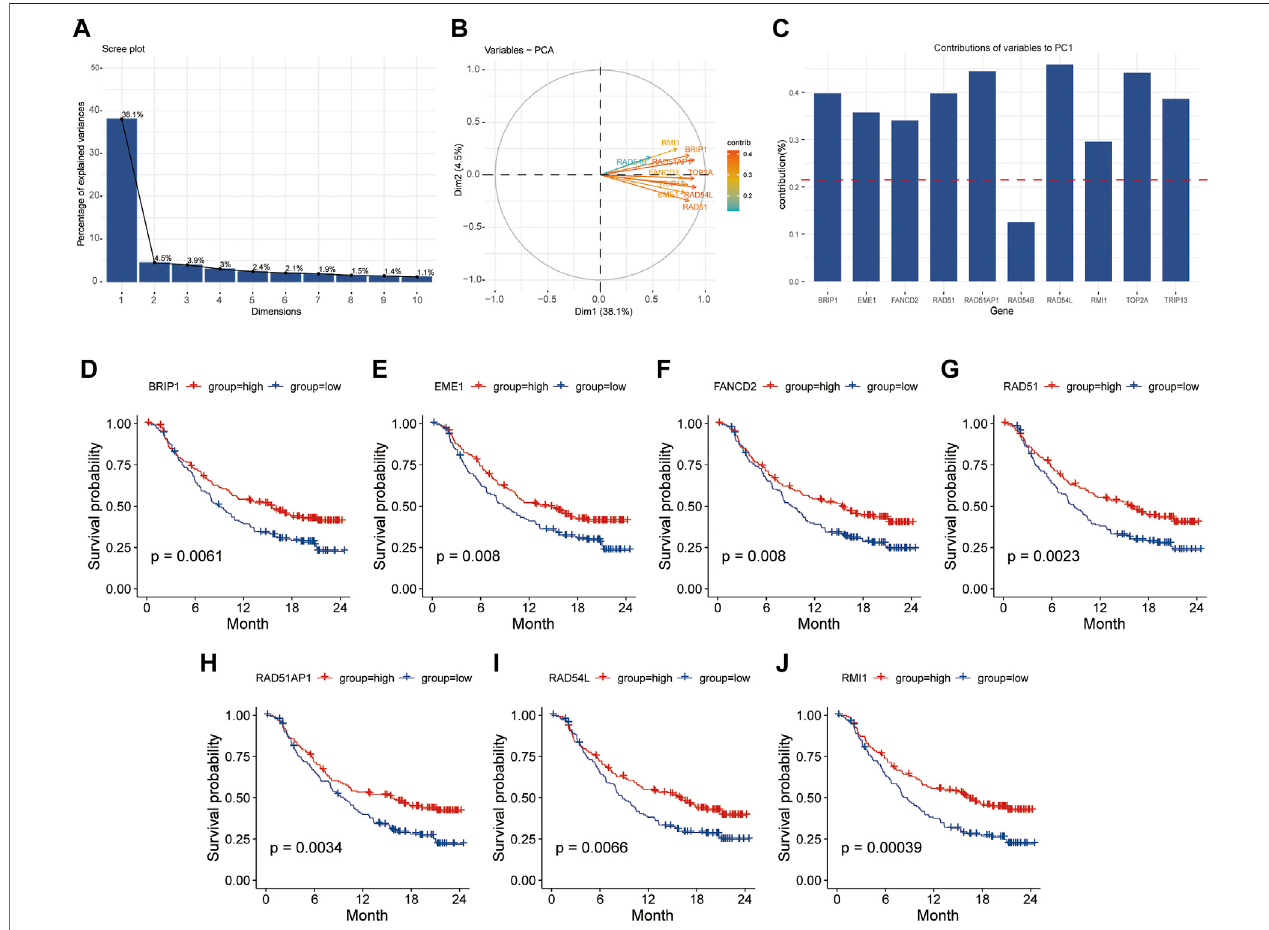
FIGURE 8 | The fi rst principal component of PCA was used to screen for HR-related genes. (A) , Explainability of different principal components to all variables; (B, C) ,ContributionofHRrelatedgenestothe fi rstprincipalcomponent. (D – J) ,Kaplan-MeiersurvivalanalysisbasedongroupingofmedianexpressionvaluesofHRrelated genes. PCA, principal component analysis; HR, homologous